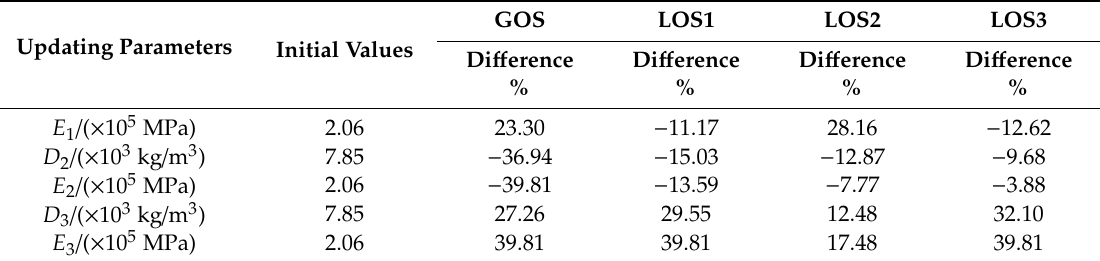
Table 11. Di ff erence of parameters before and after updating.